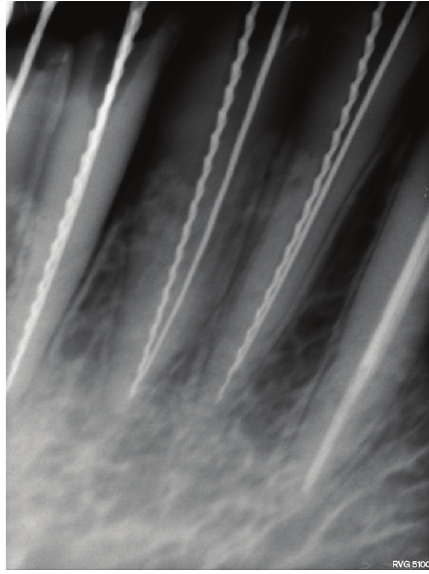
Figure 5: Radiograph showing two different instruments (“H” file and Reamer) in two canals in 41 and 42.